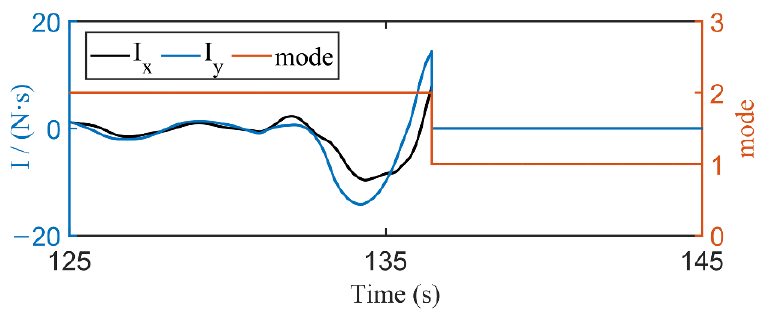
Figure 13. Forward switching parameter 𝐼.